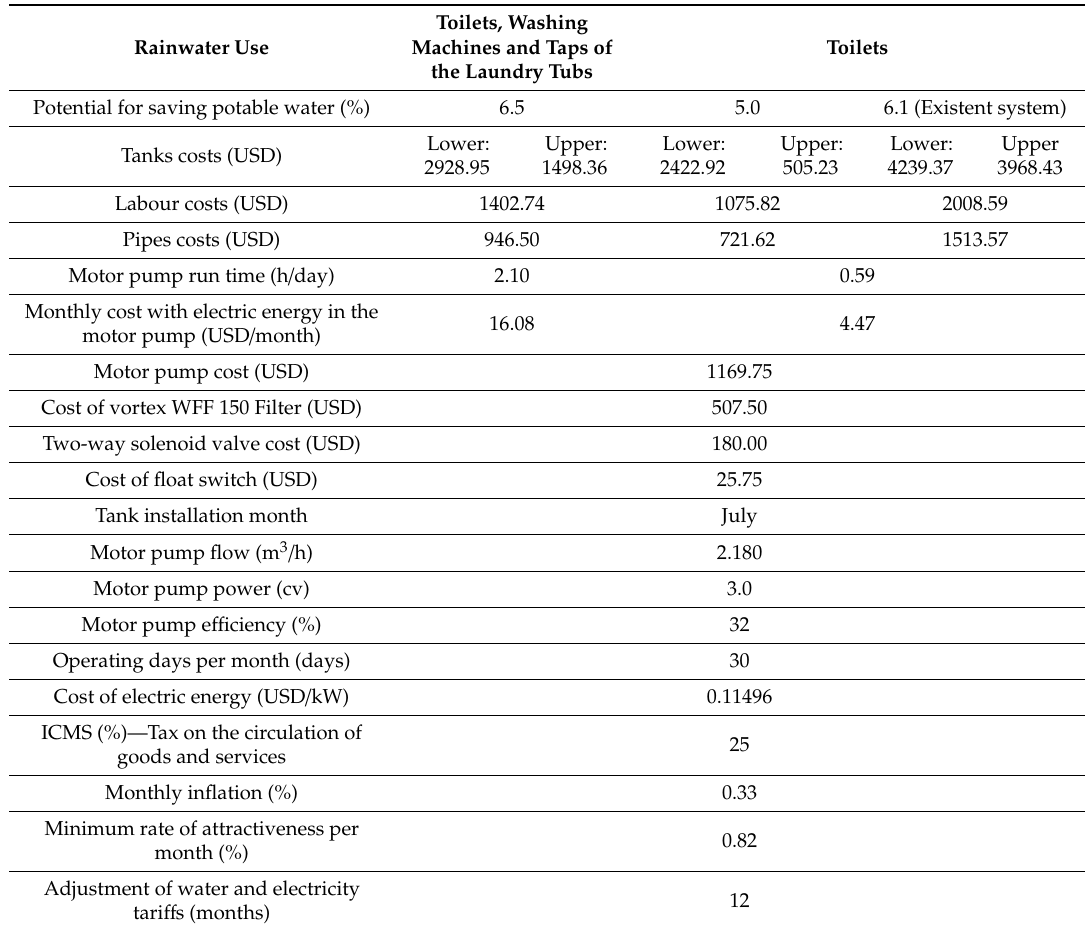
Table 7. Used in the “Netuno” programme for economic analysis of rainwater harvesting systems according to different tank capacities.